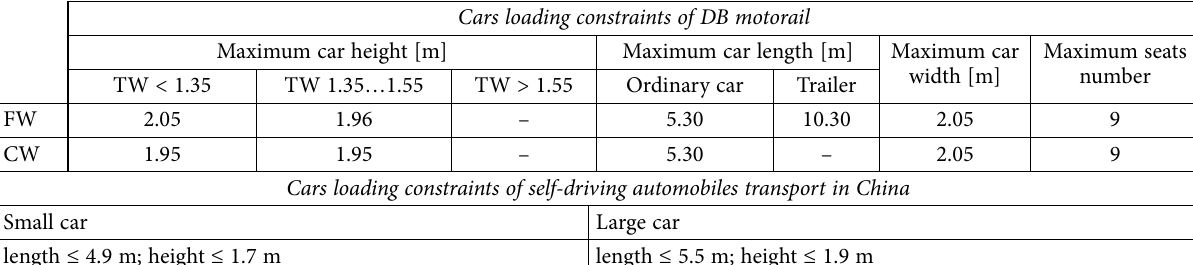
Table 1. Cars loading constraints of DB motorail and self-driving traveling trains in China (Huang, Shuai